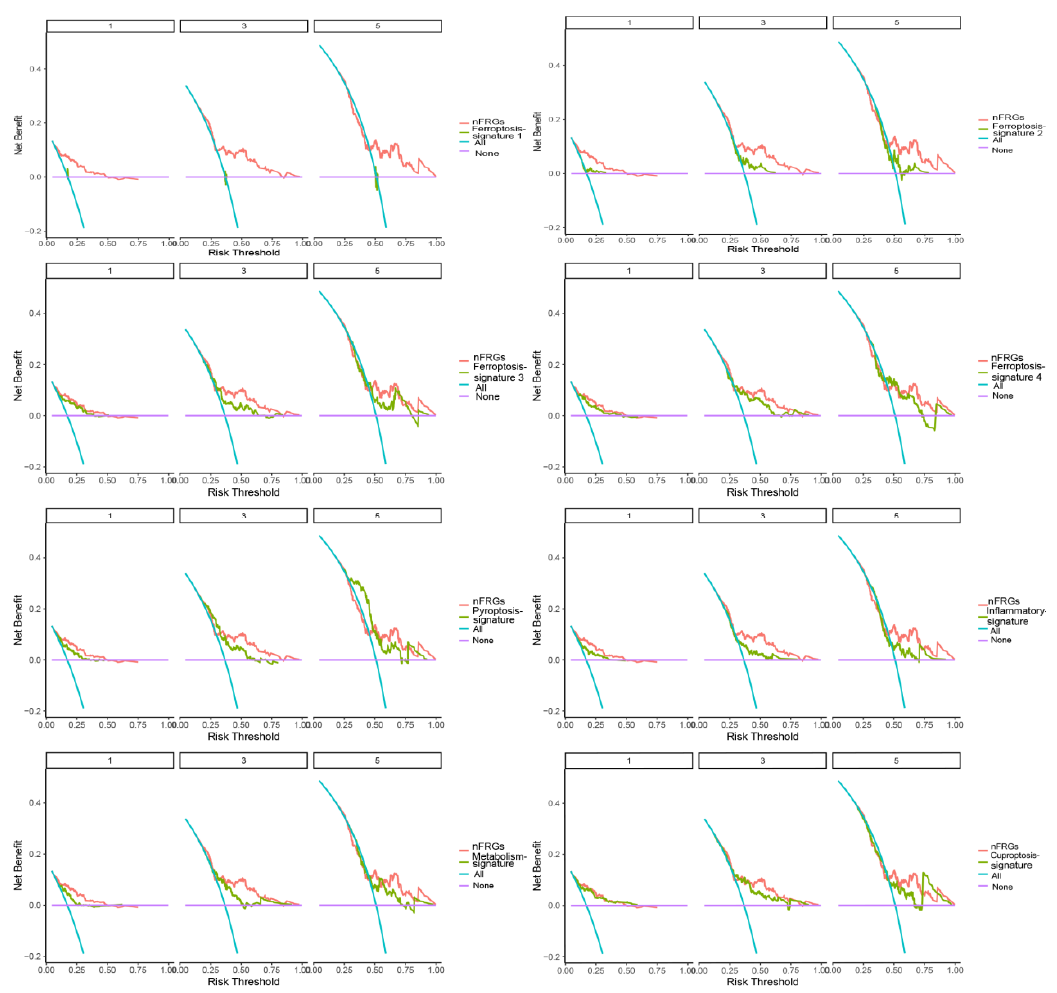
Figure 6. Comparison of nFRGs and other promising gene signatures.